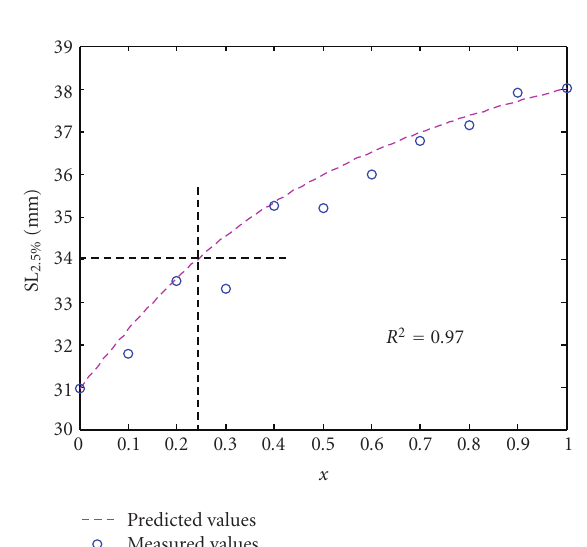
For the two length parameters SL 2 . 5% and UR%, the cor- relations are shown, respectively, in Figures 19 and 20.